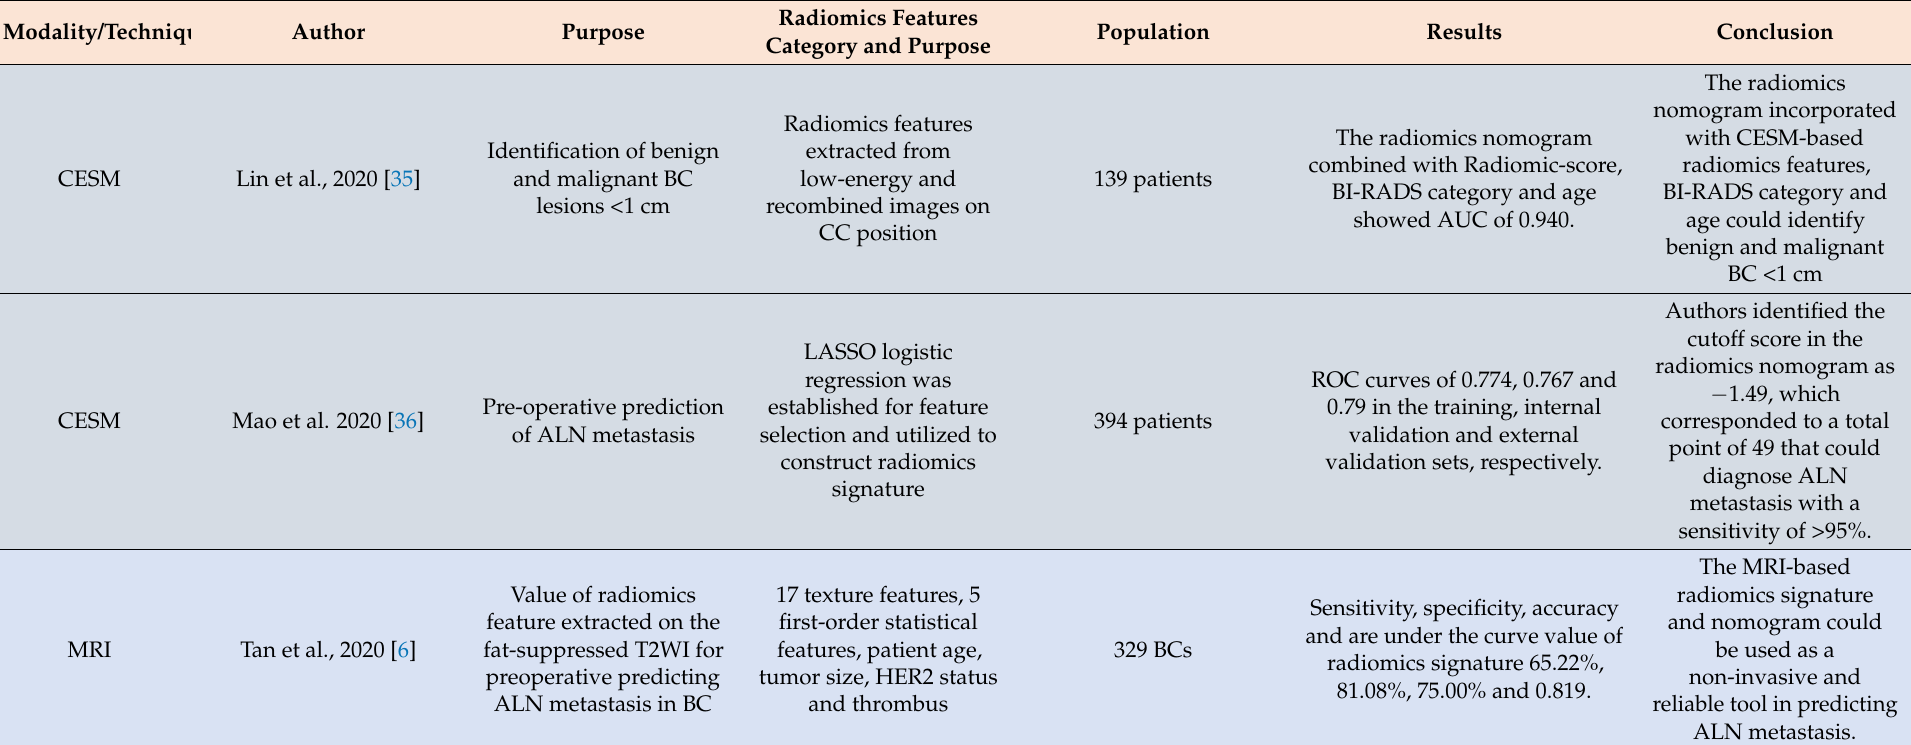
Table 1. Original studies on radiomics in breast imaging published in peer reviewed journals from 01/2018 to 01/2021, classified on modality/technique and ordered by newest first. Relevant papers were obtained with a scoping review approach, using the following set of keywords and the relative controlled vocabulary terms (Mesh/Emtree): (radiomic* OR textur*) AND (breast) AND (cancer* OR malign* OR neoplas* OR metast* OR tumor* OR tumour*). The same approach was conduct for Table 2, which includes only review papers. ALN: axillary lymph node, AUC: area under the curve, BC: breast cancer, CESM: contrast enhancement spectral mammography, DCE: dynamic contrast-enhanced, ML: machine learning, NACT: Neoadjuvant Chemotherapy, pCR: pathological complete response, SD: standard deviation, TNBC: triple-negative breast cancer, T1WI: T1 weighted imaging, T2WI: T2 weighted imaging, VOI: volume of